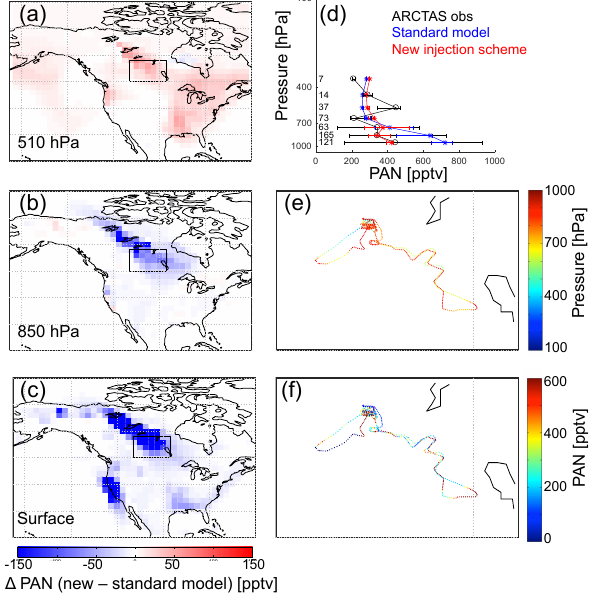
Figure 4. (a–c) Differences in simulated PAN mixing ratios be- tween a GEOS-Chem simulation with and without the new observa- tionally based biomass burning injection scheme over North Amer- ica at three different levels: 510hPa, 850hPa, and the surface on 1 July 2008. (d) Median vertical profiles of ARCTAS PAN mix- ing ratios (black), standard model (blue), and new injection scheme (red) on 1 July 2008. The whiskers represent 25% and 75% per- centiles of the data in the pressure bins. The numbers on the left are the numbers of observations in different pressure bins. (e) ARCTAS in situ aircraft observations for 1 July 2008 colored by ambient pres- sure for the inset black box in (a–c) . (f) ARCTAS observations for 1 July 2008 colored by PAN mixing ratio.